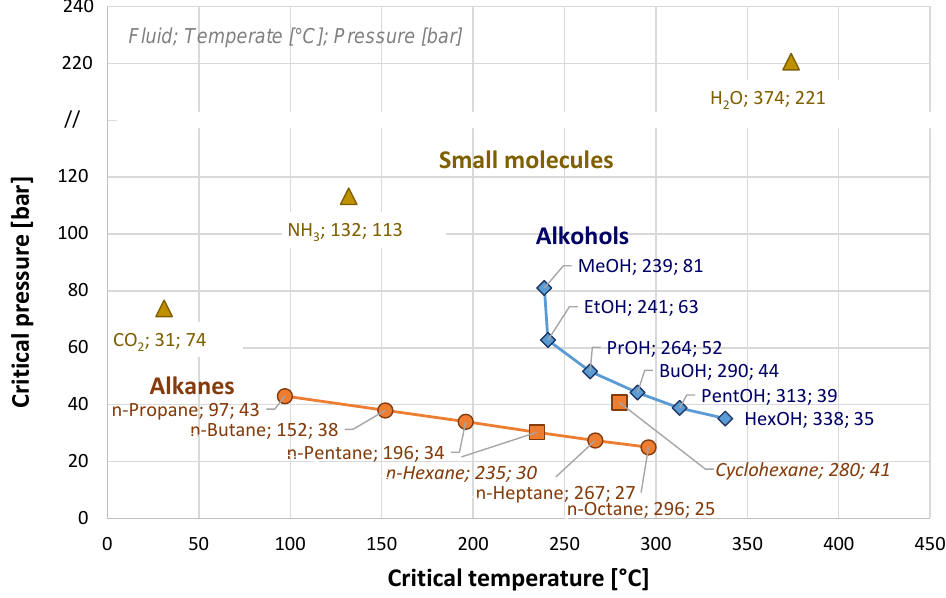
Figure 1. Critical point of common solvents. Numbers stated after the name of the solvent refer to the critical temperature [°C] and pressure [bar], respectively.